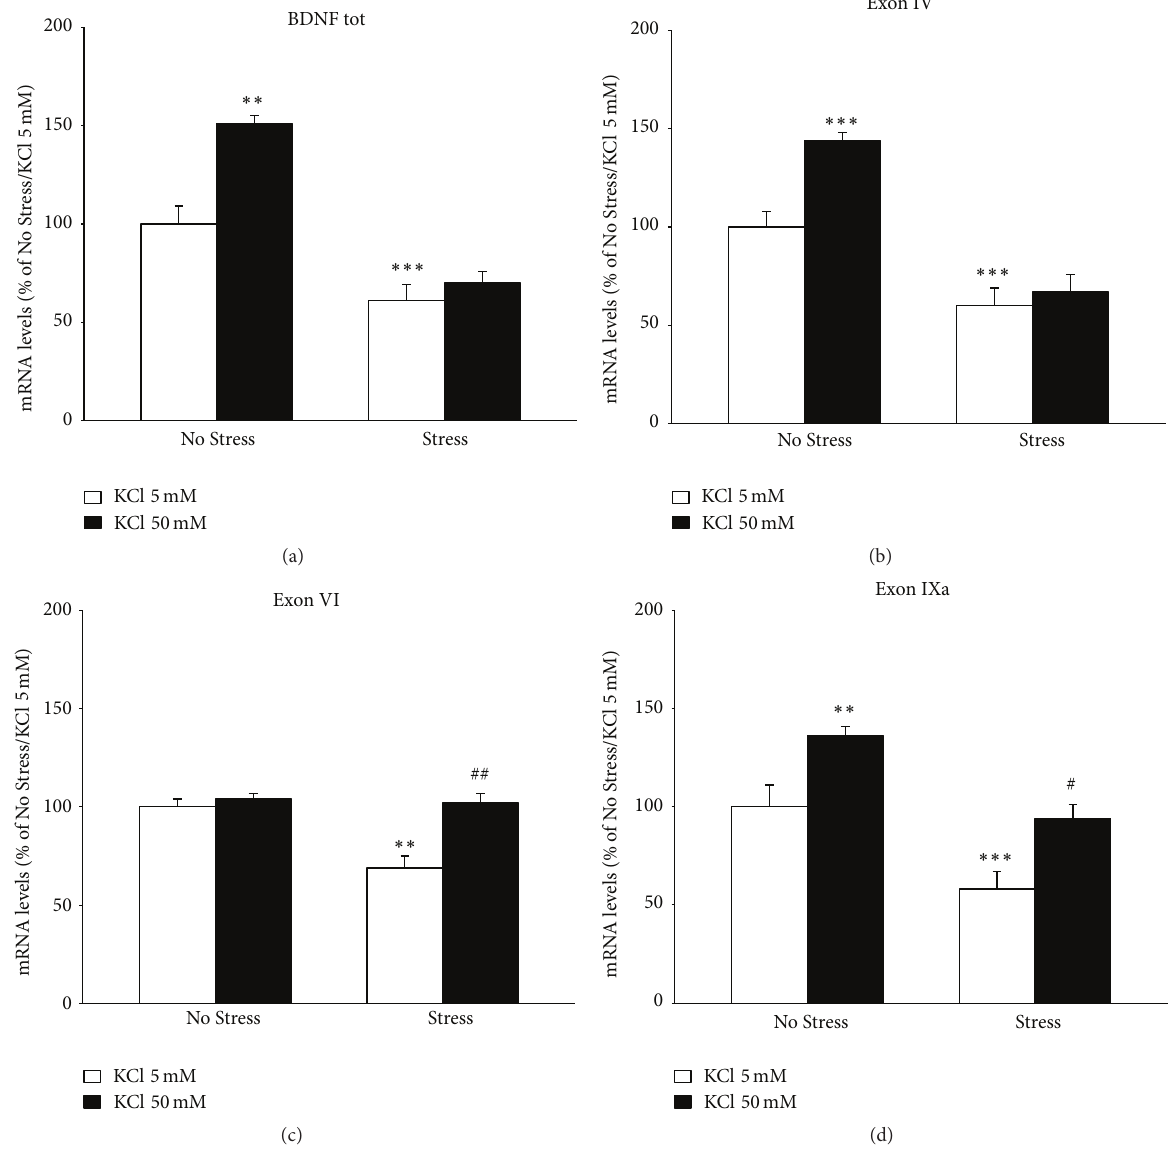
Figure 3: Analyses of BDNF gene expression. The mRNA levels of the total form of BDNF (a), BDNF isoform IV (b), isoform VI (c), and isoform IXa were measured by qRT-PCR in hippocampal slices obtained from unstressed (No Stress) or chronically stressed (Stress) rats exposed to KCl-induced depolarization (KCl 50 mM). The data, shown as a percentage referring to control group (No Stress/KCl 5 nM), are the mean ± SEM of independent determinations. ∗∗ 𝑃 < 0.01 , ∗∗∗ 𝑃 < 0.001 versus No Stress animals/KCl 5 nM; # 𝑃 < 0.05 , ## 𝑃 < 0.01 versus Stress/KCl 5nM. Two-way ANOVA with